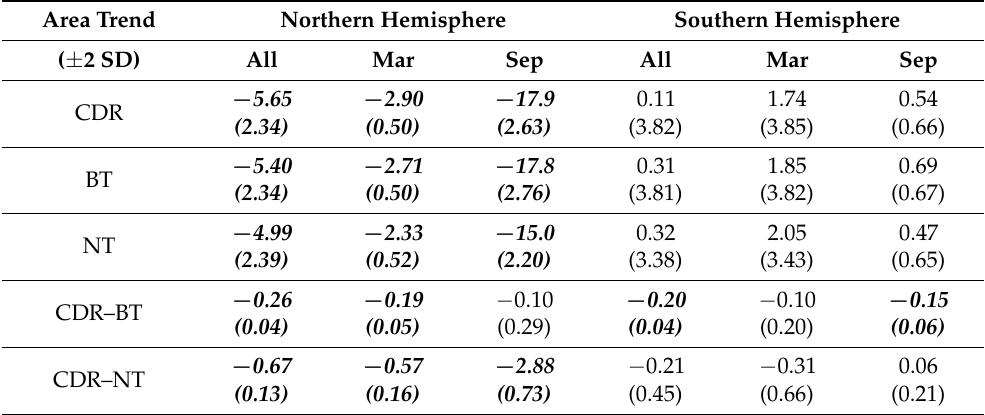
Table 2. Monthly area linear trends, in % per decade relative to the 1981–2010 CDR climatology, for both hemispheres for the entire timeseries and for March and September. The 2 standard deviation range of the trend is given in parentheses below each trend value. Statistically significant trends ( p < 0.05) are in bold italics . Area Trend Northern Hemisphere Southern Hemisphere ( ± 2 SD) All Mar Sep All Mar Sep − CDR